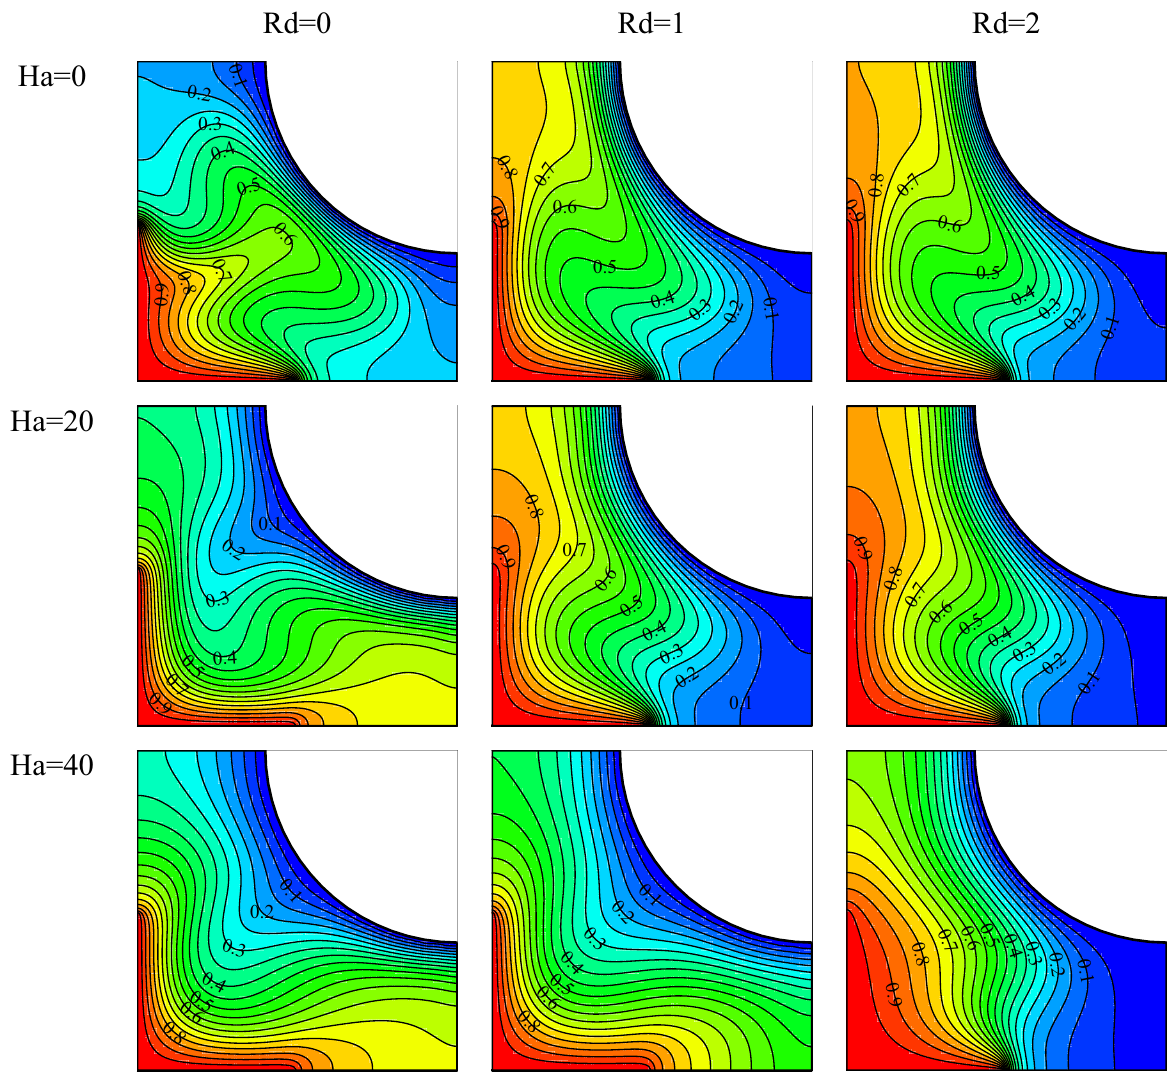
Figure 10. Temperature field for Ra = 10 5 , ω = 0, ϕ = 0.03, γ = 45 ◦ and various Hartmann numbers and radiation